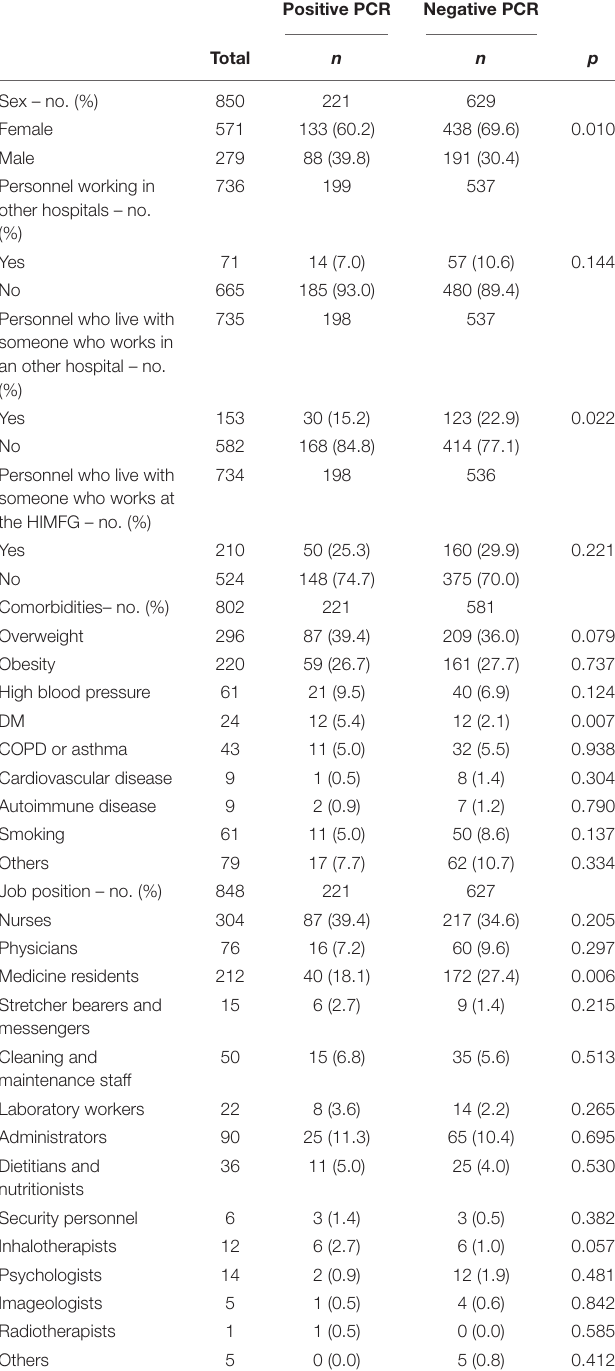
TABLE 2 | Baseline characteristics and PCR positivity.